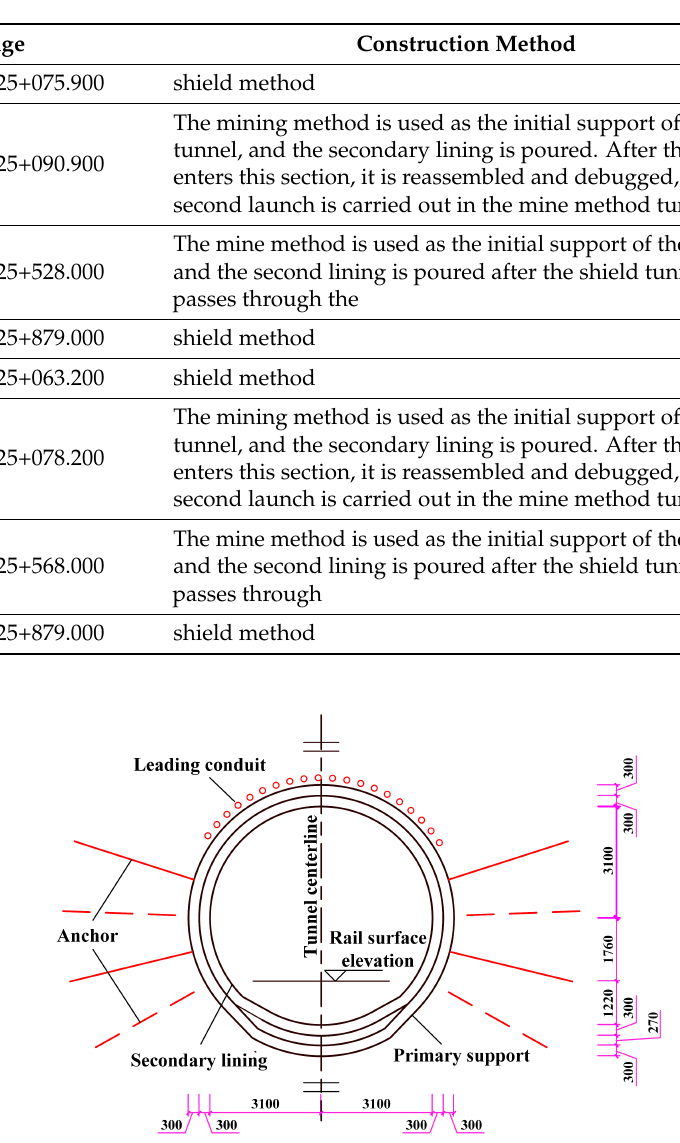
Table 2. Construction method of Jing-sha section.